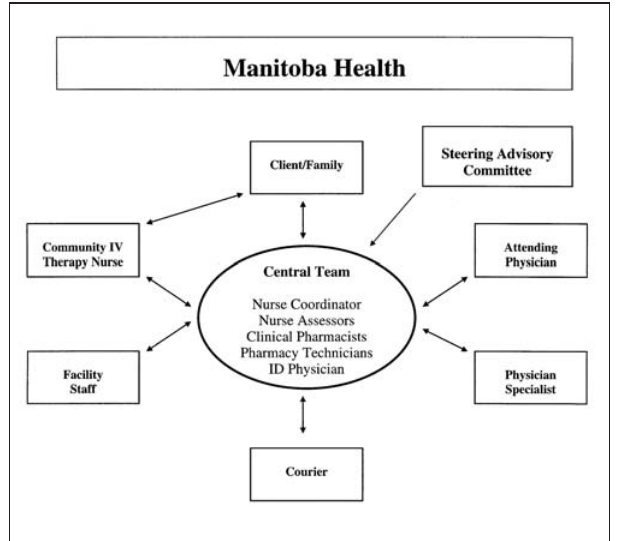
Figure 1) The Manitoba Community Intravenous Therapy